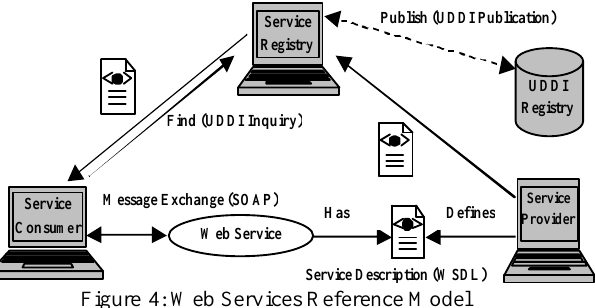
Figure 4: Web Services Reference